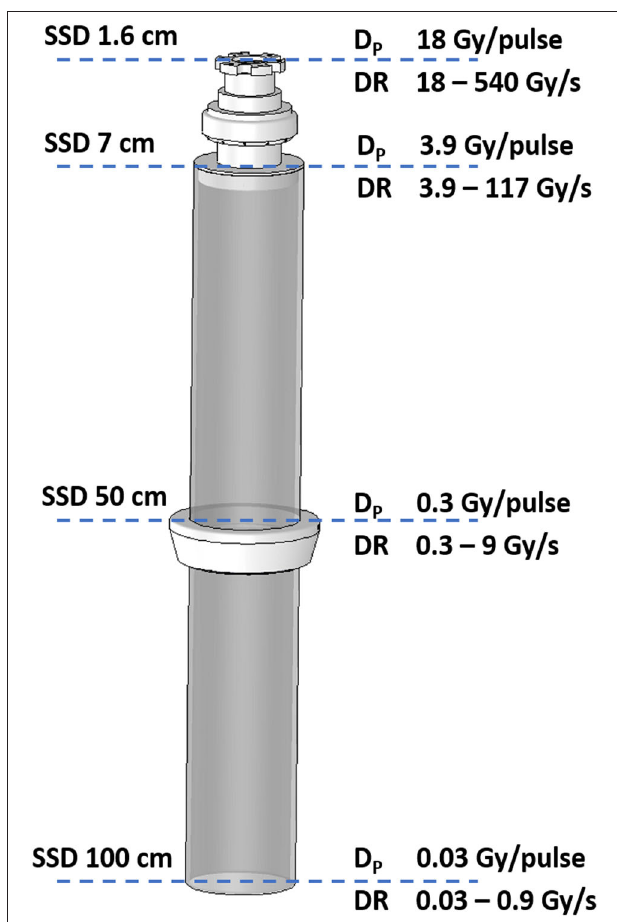
FIGURE 2 | Detail of collimator with the indications of the four SSD and the corresponding possible maximum achievable dose-per-pulse (D p ) and dose rate (DR) for the 7 MeV